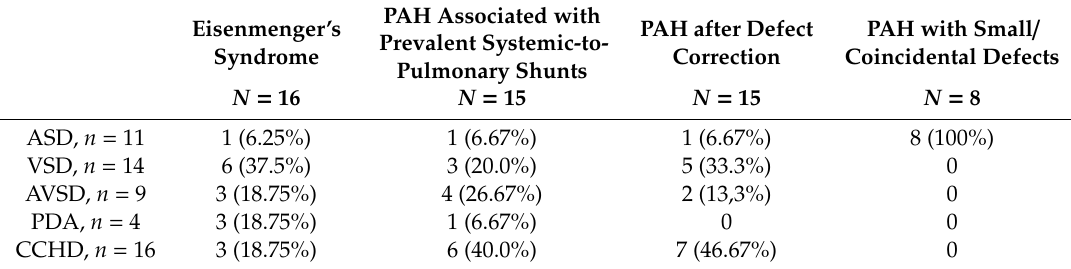
Table 2. Concomitant diseases in IPAH and CHD-PAH. 195